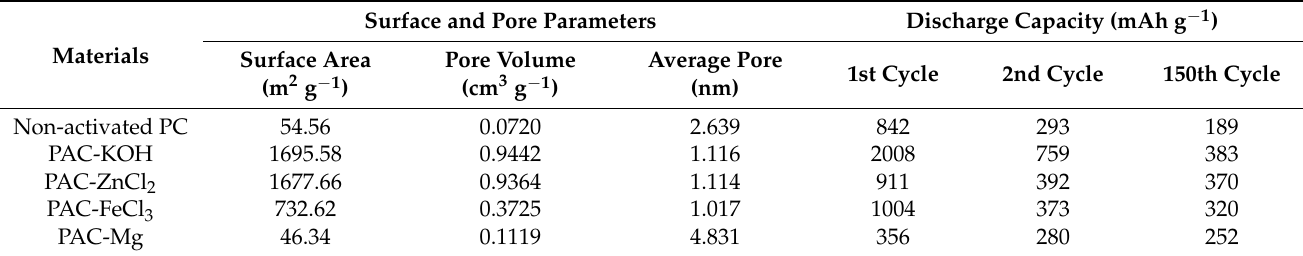
Table 1. Surface area and pore structure parameters, and capacity of non-activated PC and activated PAC